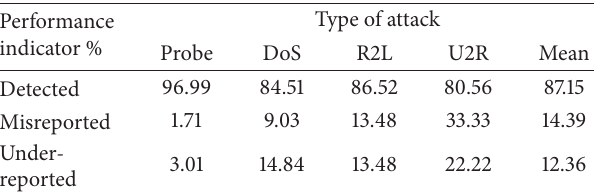
Table 5: System performance